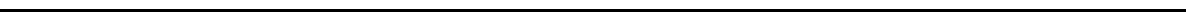
Fig. 8 Pellino2 ubiquitinates IRAK1 and suppress the inhibitory effects of IRAK1 on NLRP3. a Immunoblot analysis of myc and IRAK1 in lysates (Input) and immunoprecipitated (IP) myc samples from HEK293T cells transfected with myc-tagged Pellino2 and untagged IRAK1. b Immunoblot analysis of HA, IRAK1 and FLAG in lysates (Input) and IP IRAK1 samples from HEK293T cells transfected with FLAG-tagged Pellino2, FLAG-tagged Pellino2 RING mutant, untagged IRAK1, and HA-Ubiquitin. c, d Immunoblot analysis of Ubiquitin (short exposure (SE) or long exposure (LE)) and IRAK1 in lysates (Input) and IP IRAK1 samples or IRAK1 and ubq in TUBE-Ubq elution and cell lysates ( d ) from WT and Peli2 − / − BMDMs treated with 100 ng/ml of LPS for the indicated times. e Immunoblot analysis of NLRP3 and IRAK1 in lysates (Input) and IP IRAK1 samples from WT and Peli2 − / − BMDMs treated with 100 ng/ml LPS for the indicated times. f ELISA of IL-1 β (left panel) and TNF (right panel) in medium from primary WT and Irak1 − / − BMDMs treated with 100 ng/ml LPS for 3 h and then with 2.5 mM ATP or 5 mM Nigericin for 1 h. UT, untreated. g Immunoblot analysis of IL-1 β and Caspase-1 in medium (Sup) and lysates of WT and Irak1 − / − BMDMs stimulated with 100 ng/ml LPS for 3 h and 2.5 mM ATP for 1 h. h Immunoblot analysis of HA, NLRP3, and IRAK1 in lysates (Input) and IP NLRP3 samples from HEK293T cells transfected with V5-tagged NLRP3, untagged IRAK1, untagged kinase dead IRAK1 (IRAK1-KD), and HA- ubiquitin. β -Actin was used as loading controls. i Immunoblot analysis of Ubiquitin, NLRP3, and IRAK1 in lysates (Input) and IP NLRP3 samples from immortalized WT and Irak1 − / − BMDMs treated with 100 ng/ml LPS for the indicated times. j Immortalized WT and Irak1 − / − BMDMs were infected with MSCV as control (Ctrl) or with MSCV containing an expression construct encoding myc-tagged murine Pellino2 (Peli2), Pellino2 RING mutant (RING) or Pellino2 FHA mutant (FHA). Immunoblot analysis of myc and NLRP3 in lysates (Input) and IP myc samples from virus-infected BMDMs treated with 100 ng/ml LPS for indicated times. * p < 0.05 (paired, two-tailed Student ’ s t -test). Data are biological replicates that are representative of three independent experiments ( a-e, g-j ) or mean ± s.e.m. of three independent experiments ( f